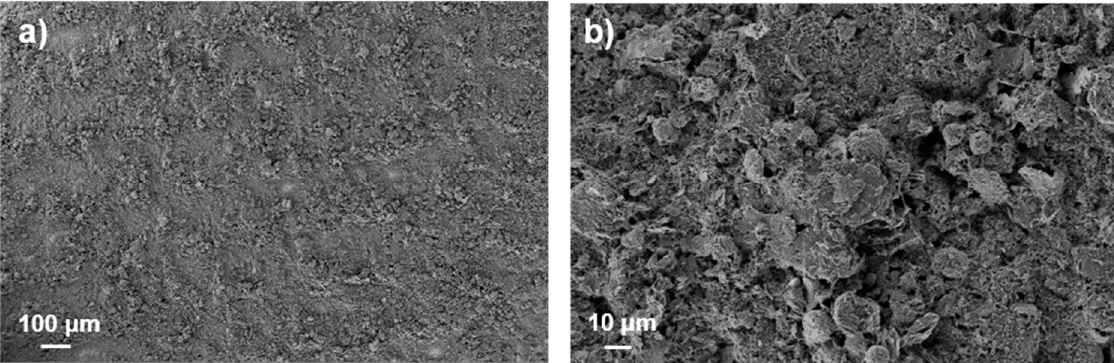
Figure 2. SEM images of the 5L anode microstructure obtained by printing ball-milled ink for three hours at 25 wt% of dry content ( a ) ×150 and ( b ) ×1400.